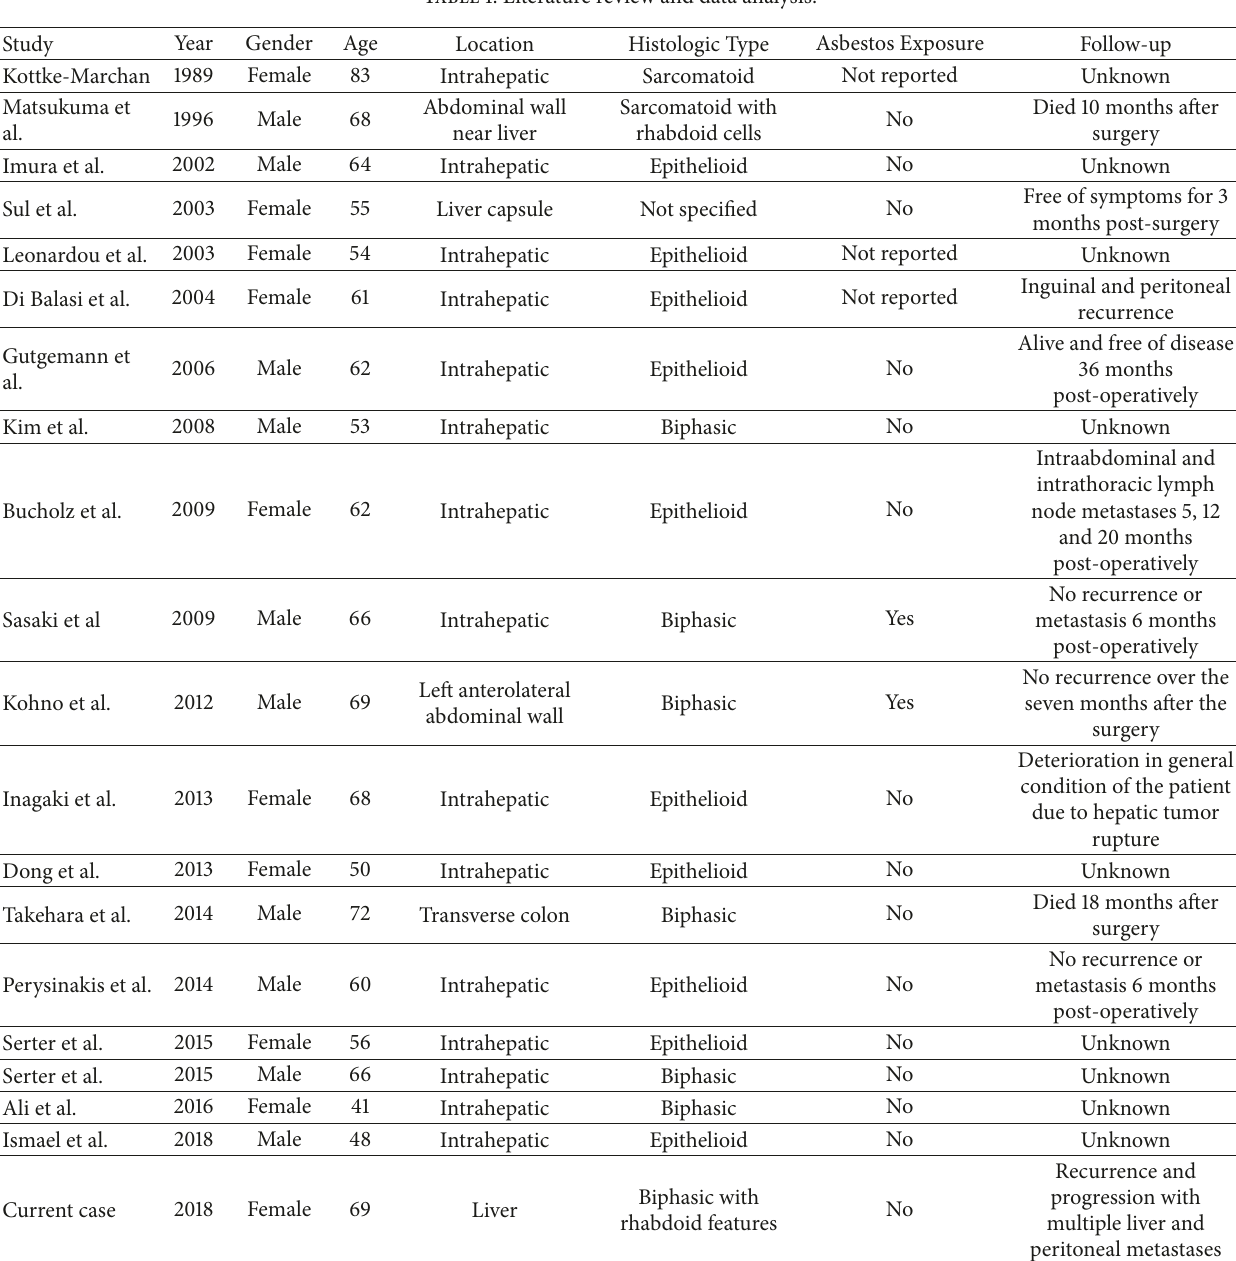
Table 1: Literature review and data